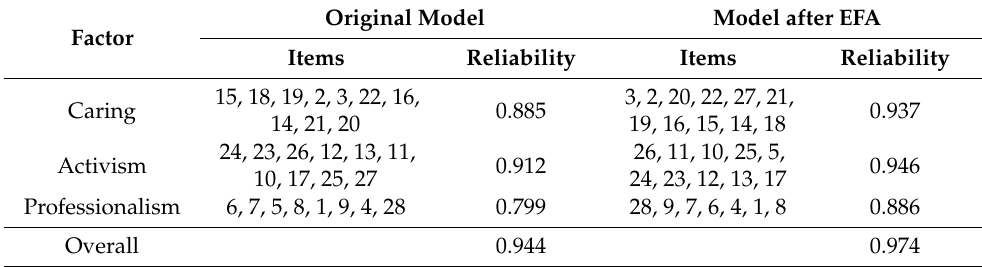
Table 4. Cronbach’s alpha and items distribution in the original and new